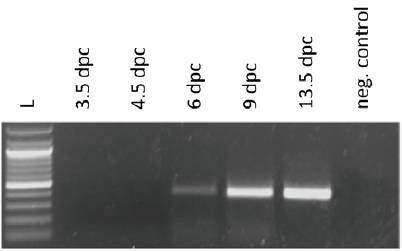
analysed in rabbit blastocysts and embryos at different time points by PCR. L-ladder, 1–3.5 dpc rabbit blastocyst, 2–4.5 dpc rabbit blastocyst, 3–6 dpc rabbit embryo, 4–9 dpc rabbit embryo, 5–13.5 dpc rabbit embryo, 6 - negative control (DNA omitted).